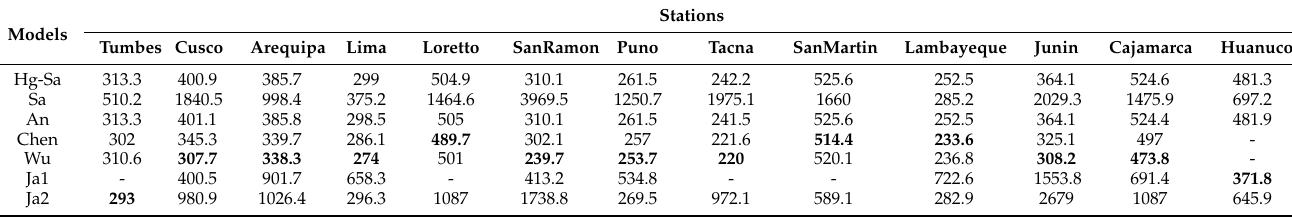
Table 4. Root mean square errors (RMSEs) (J · cm − 2 · day − 1 ) of solar radiation estimated by empirical models in selected meteorological stations (calibration set).